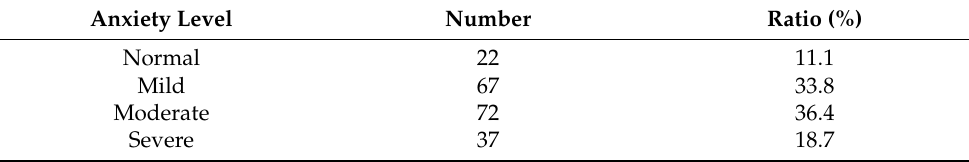
Table 2. Responses to GAD-7 (7-item Generalized Anxiety Disorder Scale) ( n = 198).